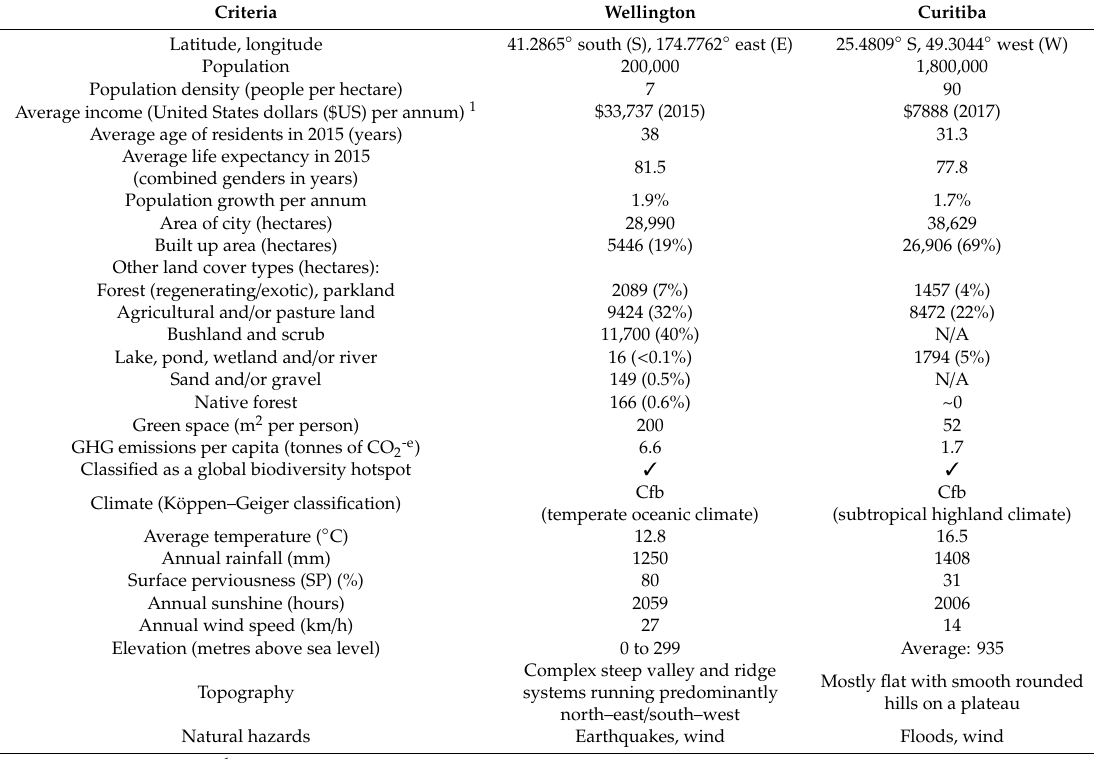
Table 2. Comparison of climate, population, and ecology between Wellington and Curitiba.